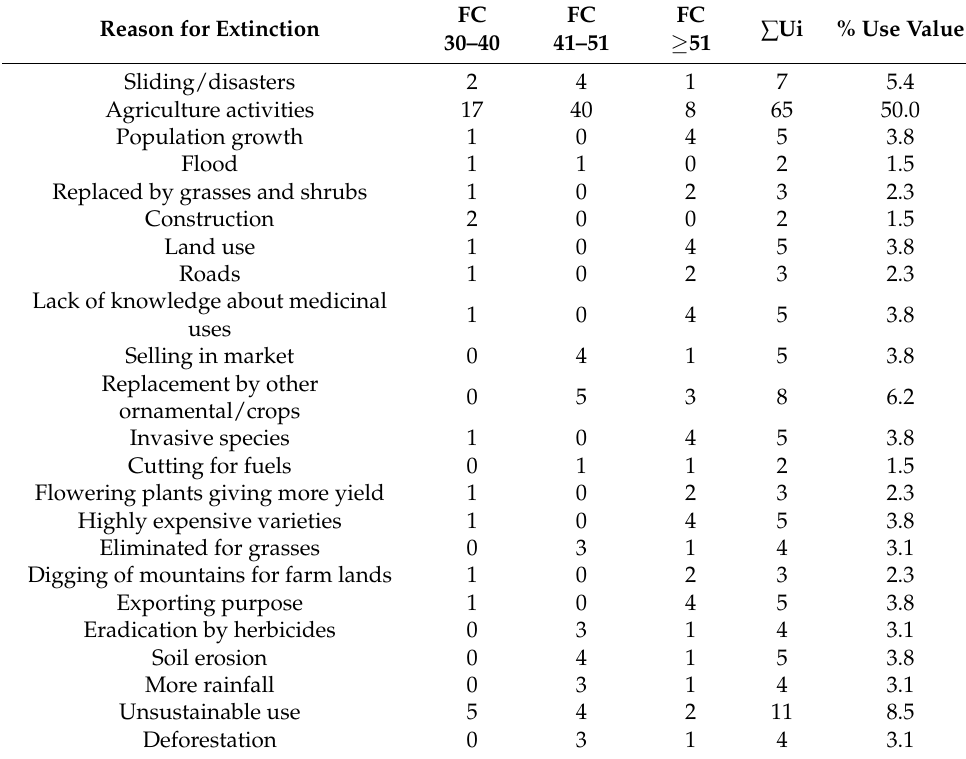
Table 3. Reasons for extinction of Berberis lyceum from the selected locality.